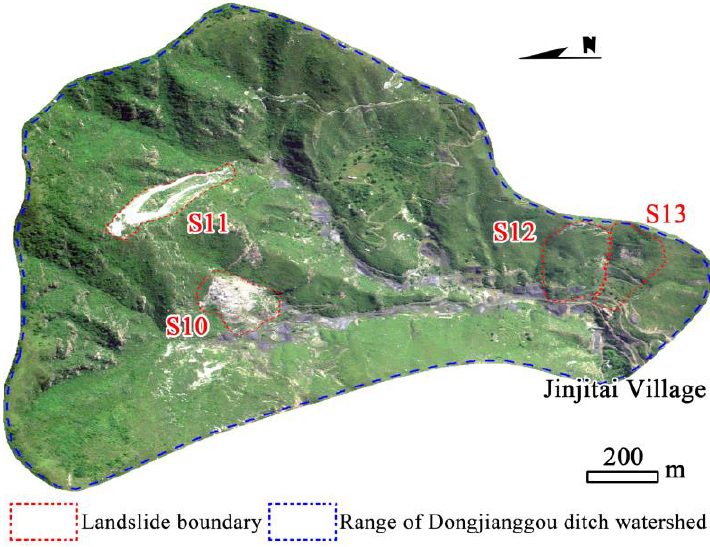
Figure 20. 3D Map of Dongjiang Ditch.